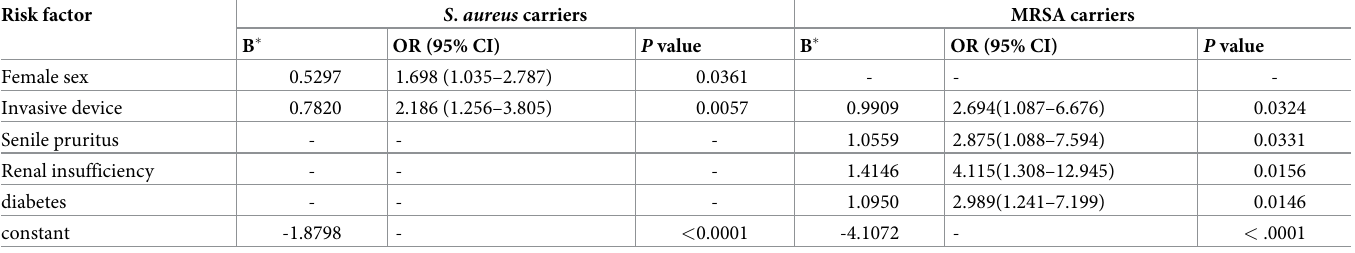
Table 8. Multivariate logistic regression analysis of risk factors associated with Staphylococcus aureus and MRSA colonization among residents in three nursing homes. Risk